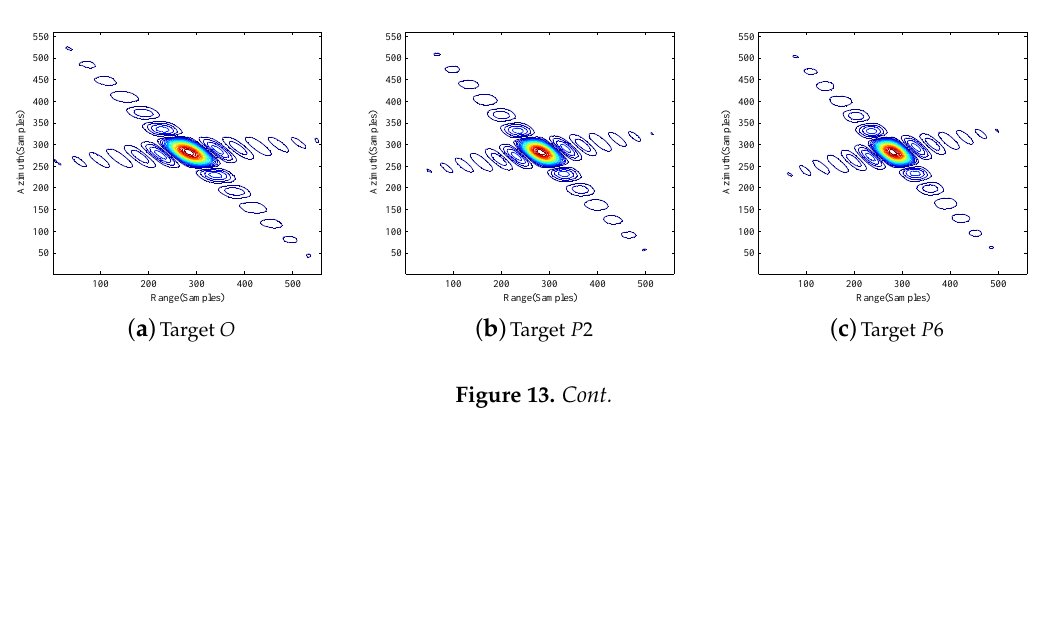
Figure 12. Imaging results. ( a )–( f ) are the imaging results processed by the proposed algorithm; ( g )–( l ) are the imaging results processed by the traditional NLCS algorithm.